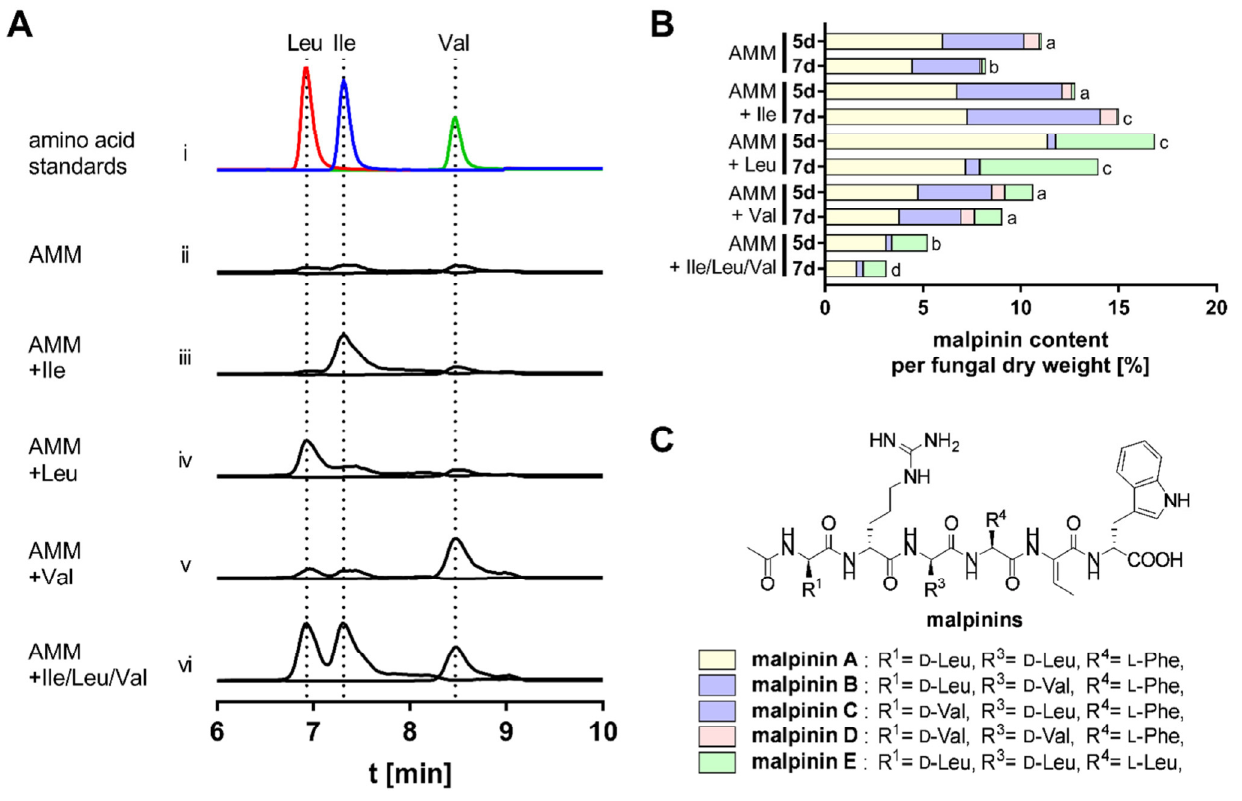
Figure 3. BCAA uptake in M. alpina and incorporation in malpinins. ( A ) UHPLC-MS profiles of cell extracts from lysed M. alpina after cultivation with additional BCAAs (Ile, Val, Leu). Commercial standards served as control (trace i). Uptake of BCAAs (traces ii-vi) is demonstrated by the extracted ion chromatograms for Val (r t = 8.4 min, m/z 118.15 [M + H] + ) and Leu/Ile (r t = 6.9/7.2 min, m/z 132.18 [M + H] + ) in an overlay mode. ( B ) Accumulated malpinin production in M. alpina by supplementation with or without Ile, Val, Leu, or all BCAAs in parallel. Cultures were harvested after 5 and 7 days, and malpinin content was determined from the supernatant by their AUCs in the EICs, using an authentic malpinin standard as reference. Values were normalized according to the fungal dry biomass and indicated as mg malpinins per g biomass. Data on total malpinin content were grouped in a compact letter display, in which samples sharing the same letter (a–d) are not significantly differently regulated to the reference condition (AMM-5d) ( p < 0.05). Note that EIC signals of the isomeric compounds malpinin B and C (both m/z 845 [M + H] + ) partially overlap, and, therefore, a combined quantification for both metabolites was carried out. ( C ) Chemical structures of malpinins A–E. For statistical analysis of quantification, see Table S5.